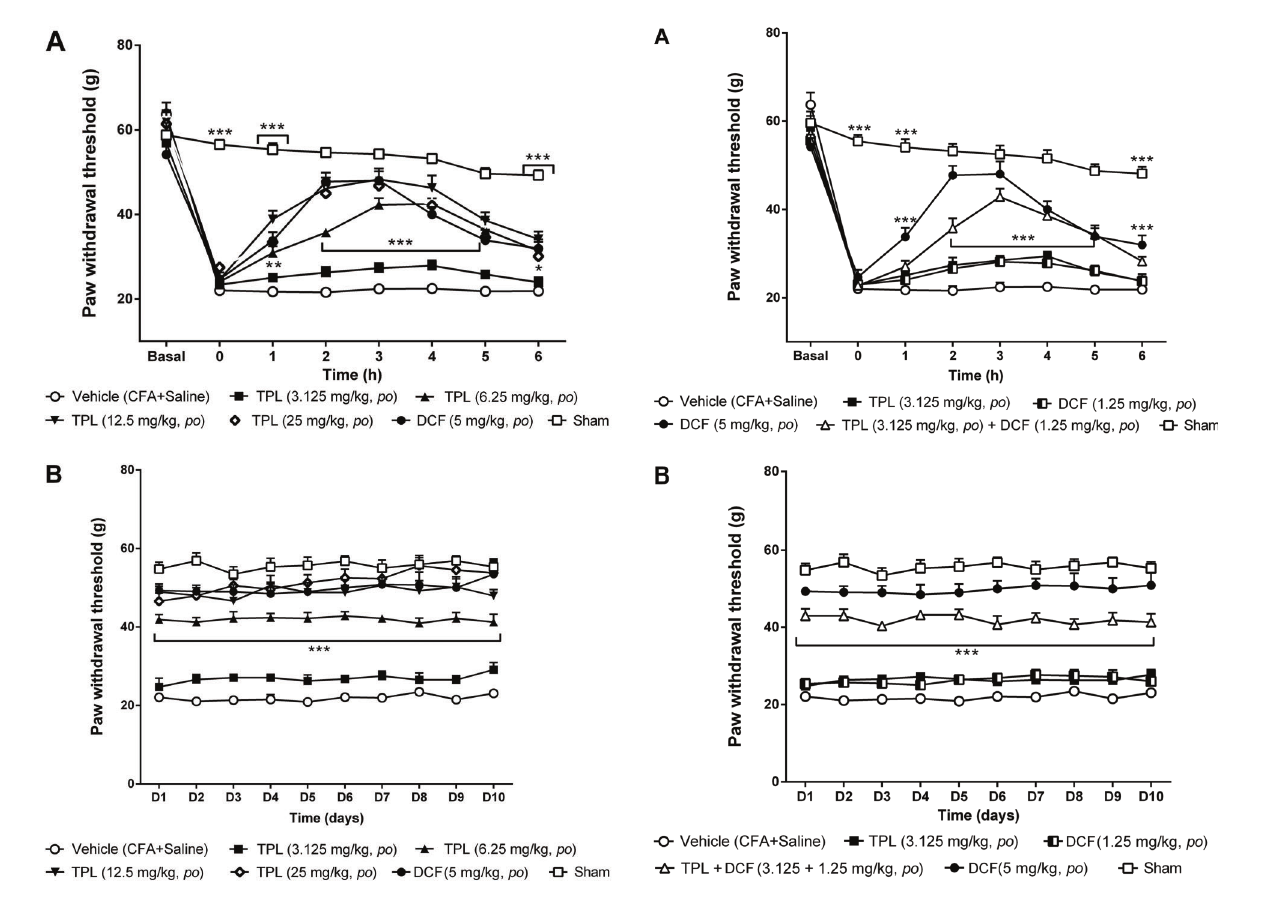
Figure 5. Effect of acute ( A ) and chronic ( B ) administration of terpinolene monoterpene (TPL)/diclofenac (DCF) association. Each point represents the mean ± SEM of the paw withdrawal threshold in female Wistar rats (n=6 – 8) with mechanical hyperalgesia induced by Freund ’ s complete adjuvant (CFA) (50 m L/paw) injection ( ipl ) subjected to the Randall Selitto test. ***P o 0.001 compared to vehicle group (two-way ANOVA, Bonferroni